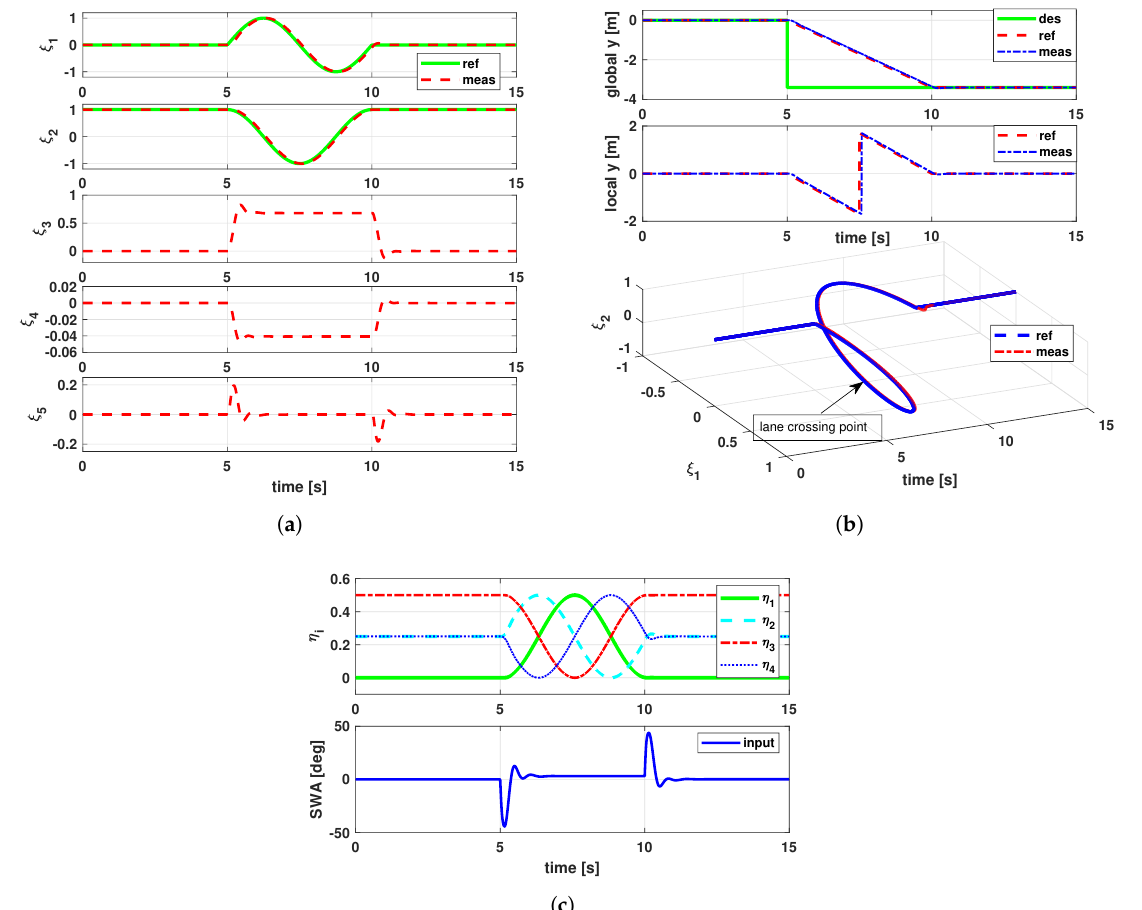
Figure 5. Result of ALCS using formal sine and cosine trajectory. ( a ) Reference and measured states in the cylinder domain; ( b ) Trajectory of vehicle in global, local and cylinder domain, respectively; ( c ) Convex interpolation parameter and the control